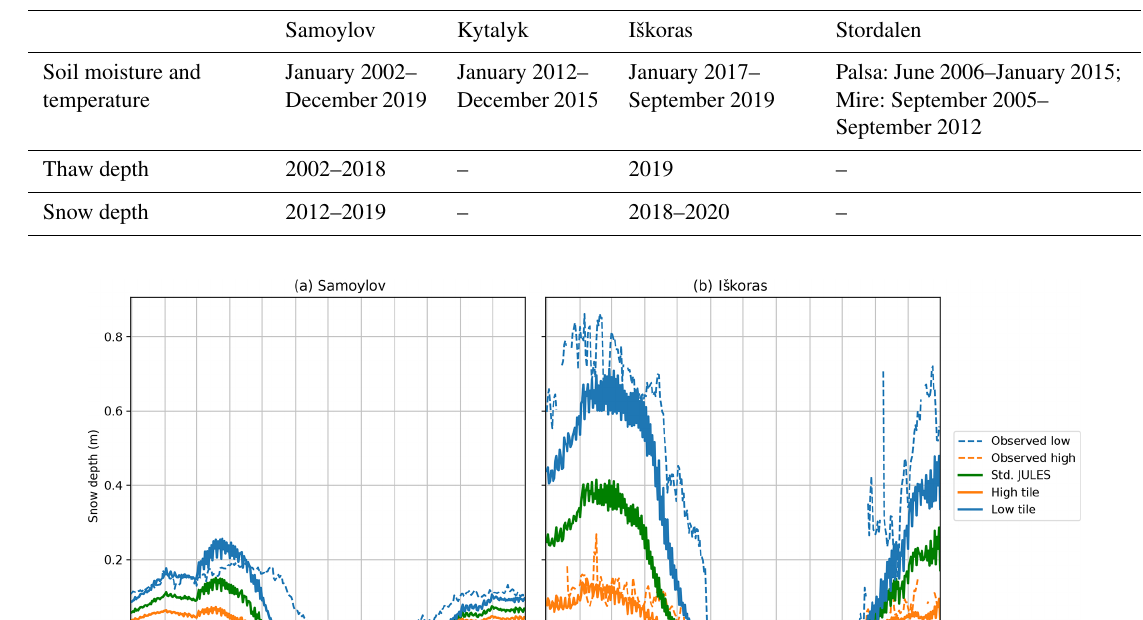
Table 4. Date ranges of available observations.